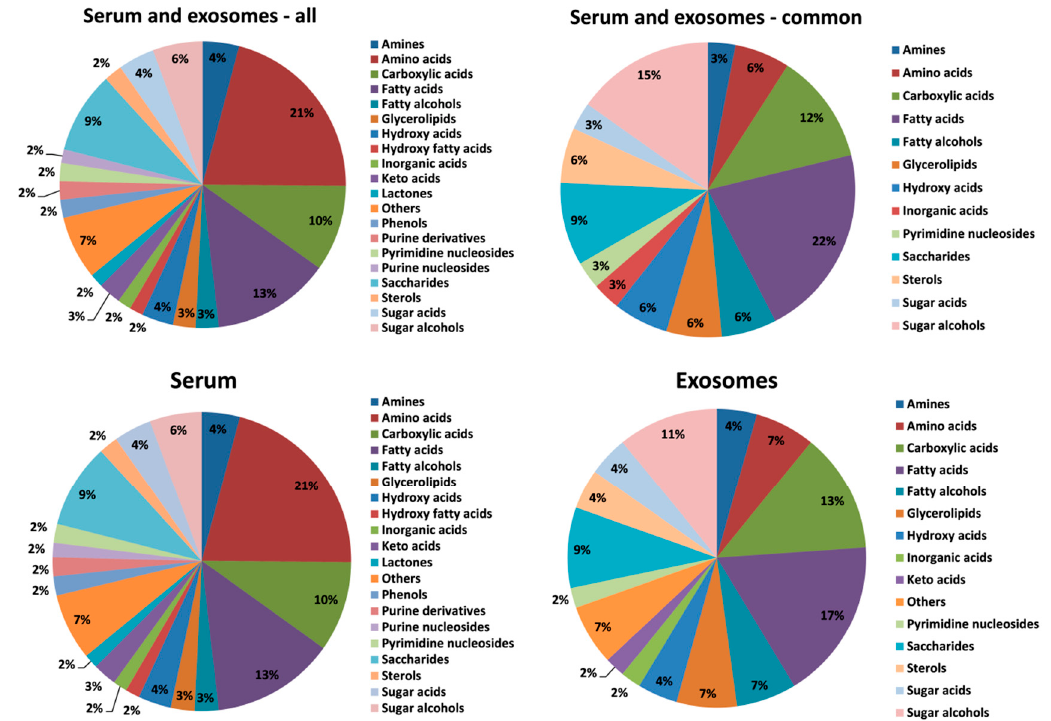
Figure2. Therelativecontributionofdi ff erentclassesofmetabolitespresentinserumandserum-derived Figure 2. The relative contribution of different classes of metabolites present in serum and serum- exosomes (metabolites detected in all types of analyzed samples were derived exosomes (metabolites detected in all types of analyzed samples were considered).